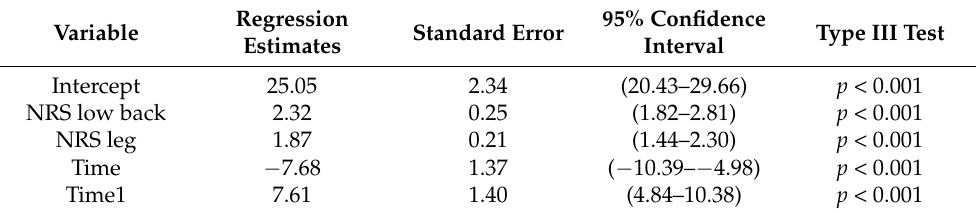
Table 1. Regression coefficient estimates and their 95% confidence intervals, based on the final